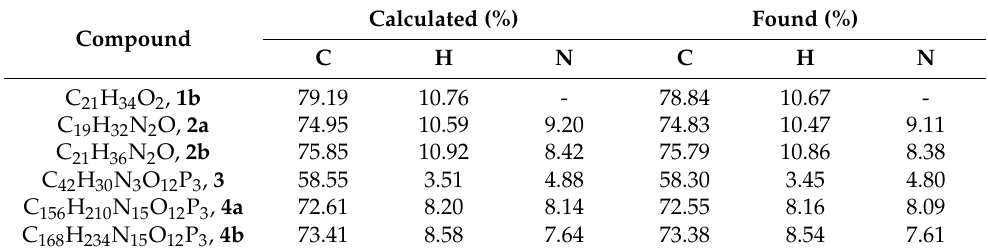
Table 2. CHN elemental analysis of compounds 1b , 2a – b , 3a , and 4a – b .